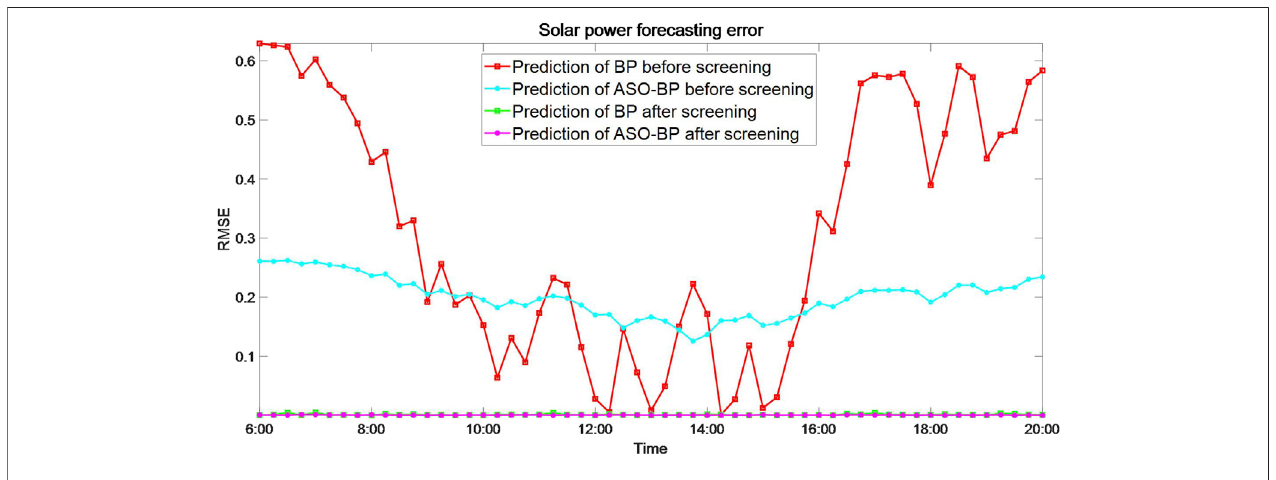
FIGURE 4 | RMSE of the two models based on two samples.